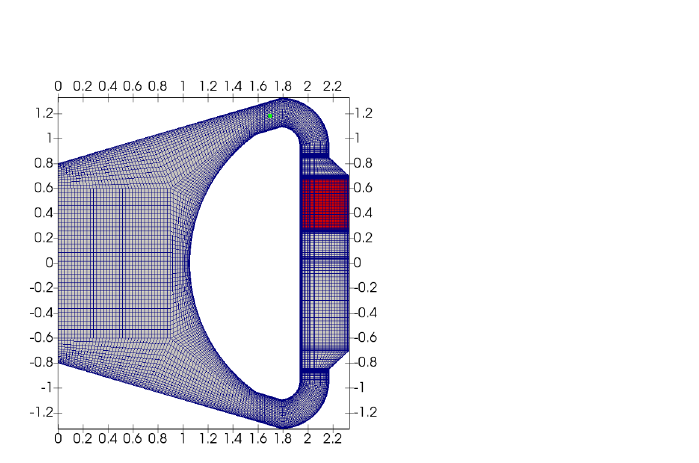
Figure 1: 2D axisymmetric geometry of the MSFR used for the numerical example. (red: pump region, green: probe location, gray: regular flow domain)